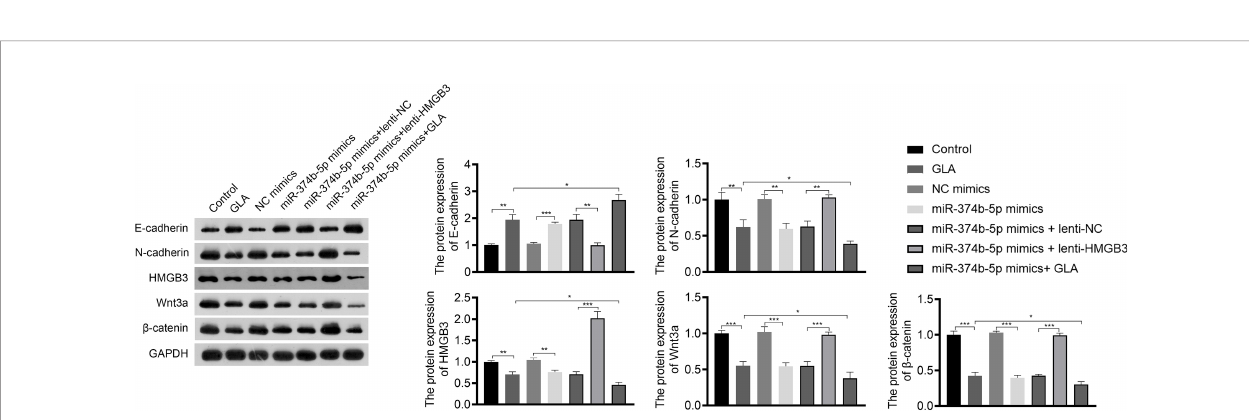
FIGURE 7 | GLA inhibited the expression of EMT and Wnt- b -catenin pathway-related proteins via regulating miR-374b-5p/HMGB3 axis. The relative protein expression of E-cadherin, N-cadherin, HMGB3, Wnt3a, and b -catenin in SKOV3 cells in SKOV3 cells was detected by western blotting. SKOV3 cells were treated with GLA, miR-374b-5p mimics/NC mimics, and/or lenti-HMGB3/lenti-NC. * P < 0.05, ** P < 0.01, *** P < 0.001.